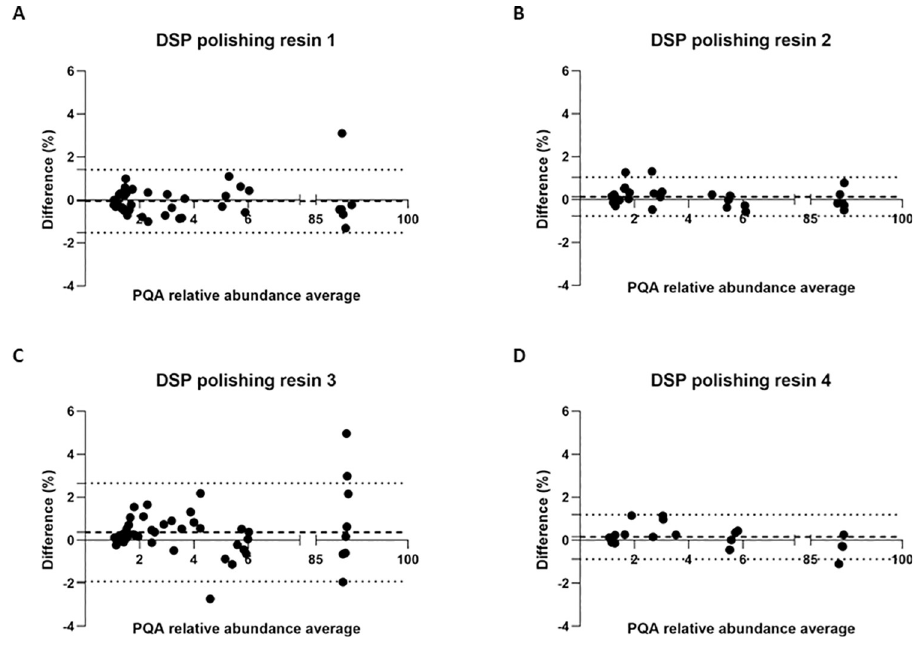
Fig 6. Bland-Altman plots to assess comparability of a polishing platform between two different laboratories. Differences between the PQA values (relative abundances > 1%) obtained for 4 different polishing resins (A-D) at two purification scales (1 mL and 15 mL resin volume; n = 1 per scale and laboratory) are plotted (PQAs were evaluated in three selected fractions for each resin/scale). The dotted lines represent the limits of agreement given by the 95% confidence intervals for the mean bias, and the dashed line represents the mean bias from the Bland-Altman plot (the closest to zero the more similar are the results under evaluation, see section Statistical Analysis from Materials and Methods for more